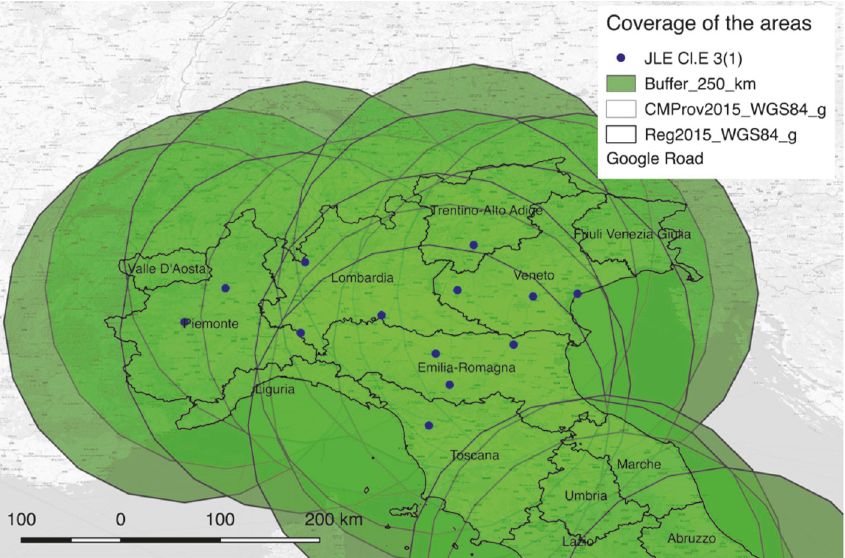
Figure 13: Definition of the coverage of the areas by minor airports through the country: